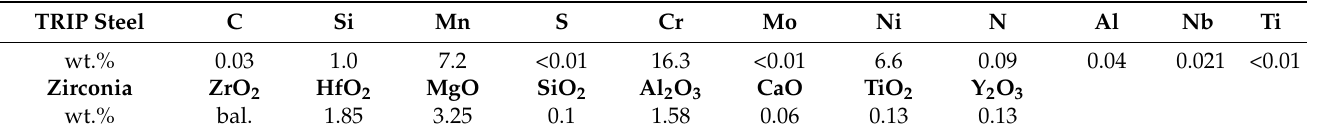
Table 1. The chemical composition of the gas X3CrMnNi16–7–6 atomized TRIP steel (Fe balance) and Zirconia by weight [24].